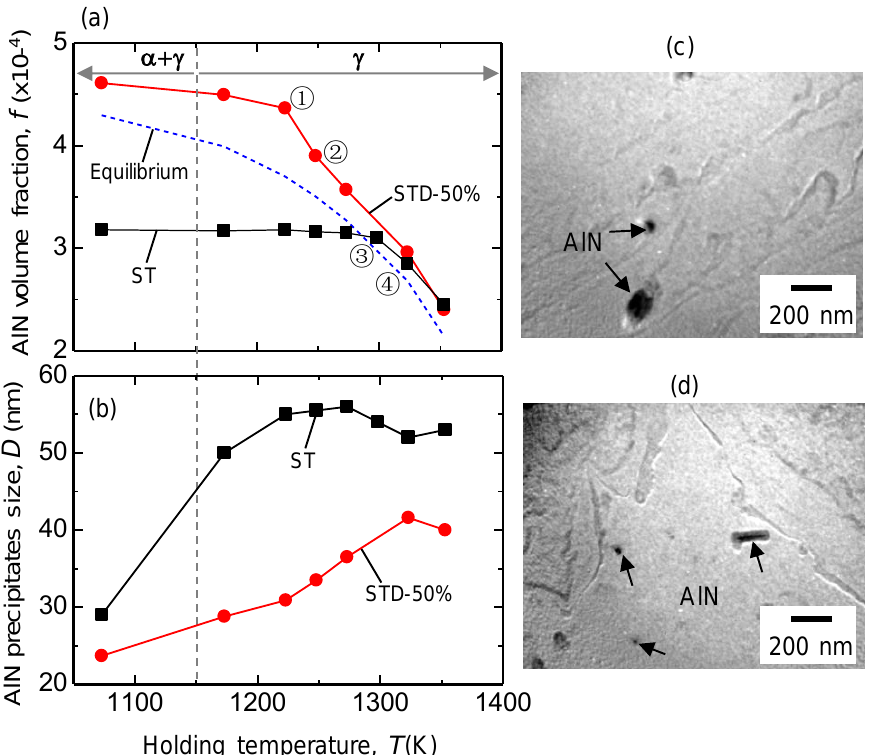
Figure 5. ( a ) Volume fraction and ( b ) size of the AlN particles in the ST and STD-50% specimens after annealing at various temperatures for 1800 s. TEM images of the AlN particles (indicated by the black arrows) in ( c ) ST and ( d ) STD-50% specimens after annealing at 1173 K for 1800 s.